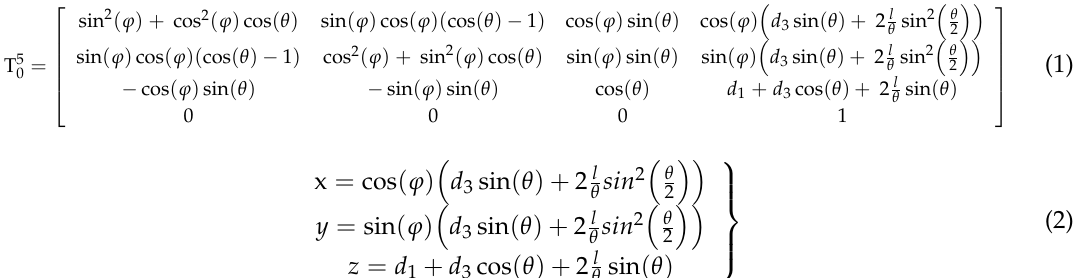
Link ( i ) α a d # 1 − π 0 d 1 ϕ 2 2 π 0 0 θ 2 3 − π 0 d 2 0 2 4 π 0 0 θ 2 5 0 0 d